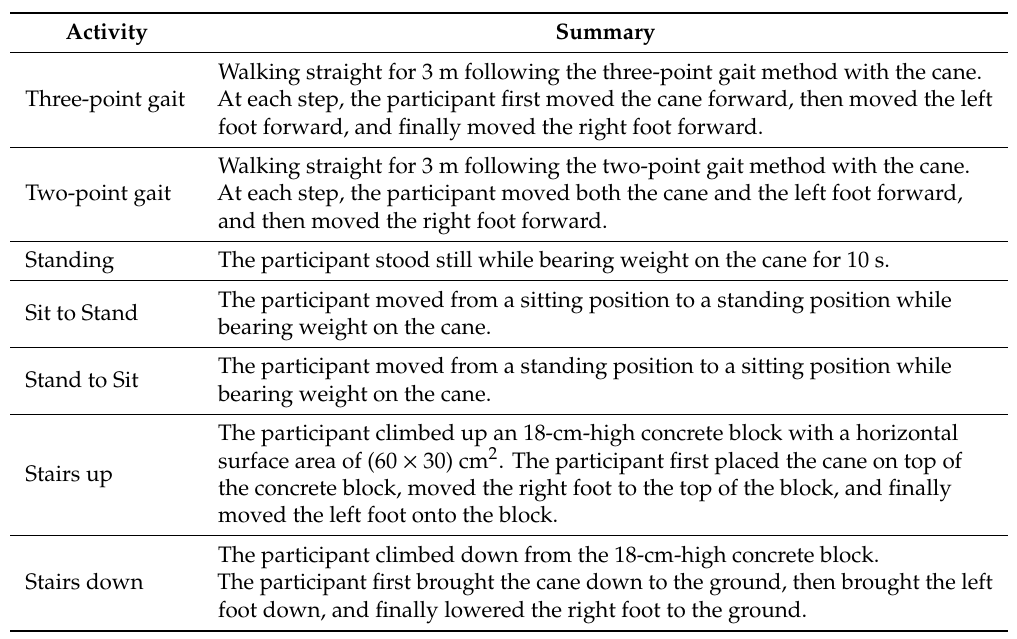
Table 1. Summary of the activities performed in the experiment.